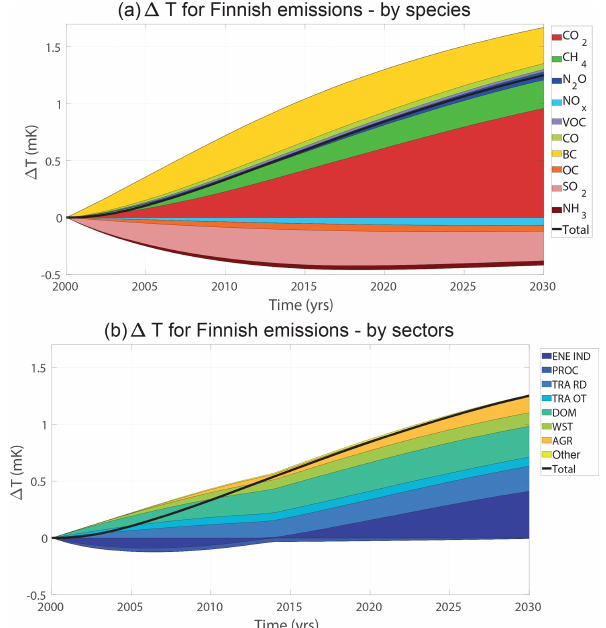
Figure 5. The global temperature development (mK) of Finnish emissions for the period 2000–2030. Temperature is given by pol- lutants in (a) and by sectors in (b) . The global temperatures are es- timated as a convolution of ARTP values and an emission scenario.